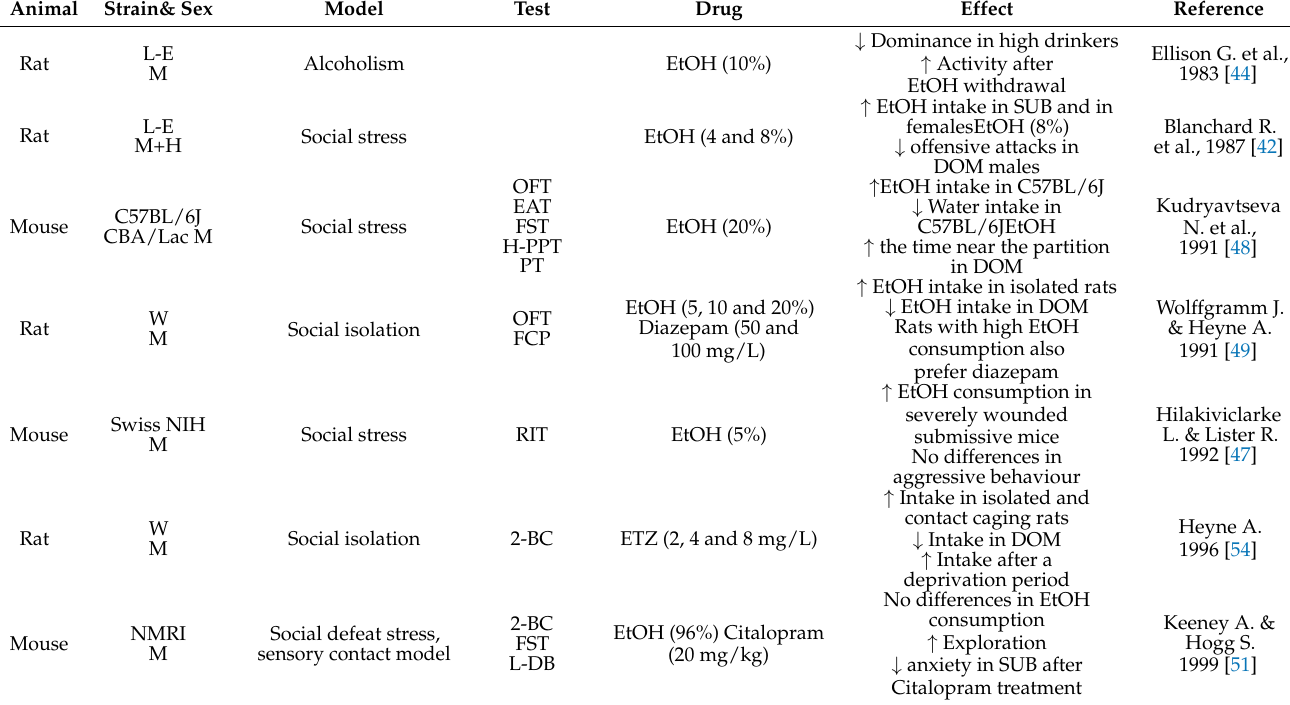
Table 3. Social stress and depressant